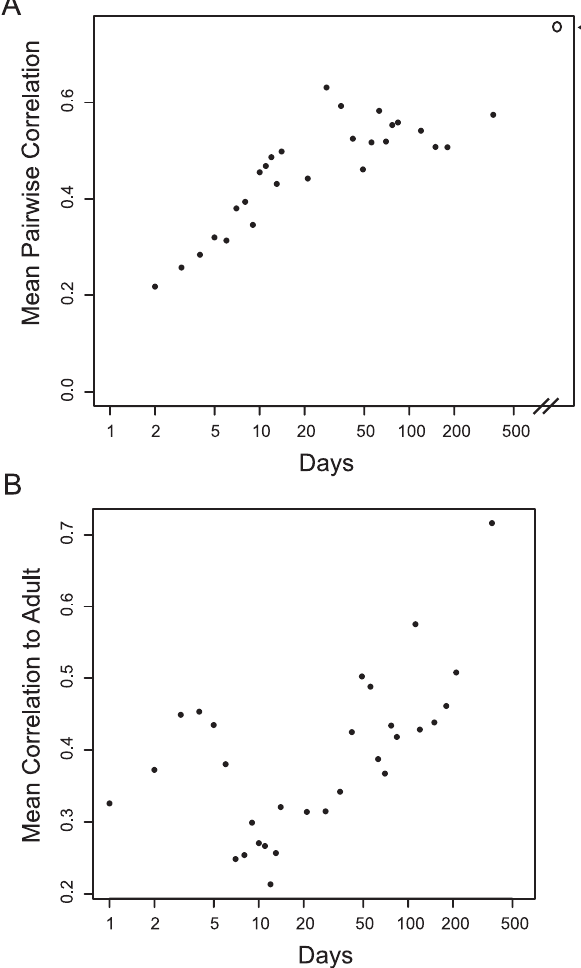
Figure 6. Temporal Patterns in Average Pairwise Similarity of Infant Stool Microbiota Profiles (A) Similarity between infants over time. For each time point for which at least six babies were profiled, we calculated the mean pairwise Pearson correlation between the level 4 taxonomic profiles of all babies at that time point. The mean pairwise Pearson correlation between these profiles in 18 adult participants in this study (nine males and nine females) is also shown (open circle indicated by the arrow). (B) Progression towards adult-like flora over time. For each time point for which at least four babies were profiled, we calculated the mean Pearson correlation between the level 4 taxonomic profiles of all babies at that time point and a ‘‘ generic adult ’’ profile. The generic adult profile is the centroid of 18 (nine male and nine female) adults (parents in this study).